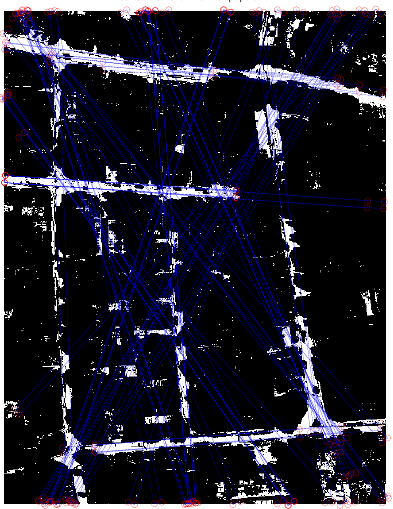
Figure 6. Best 50 candidates of the final GA generation